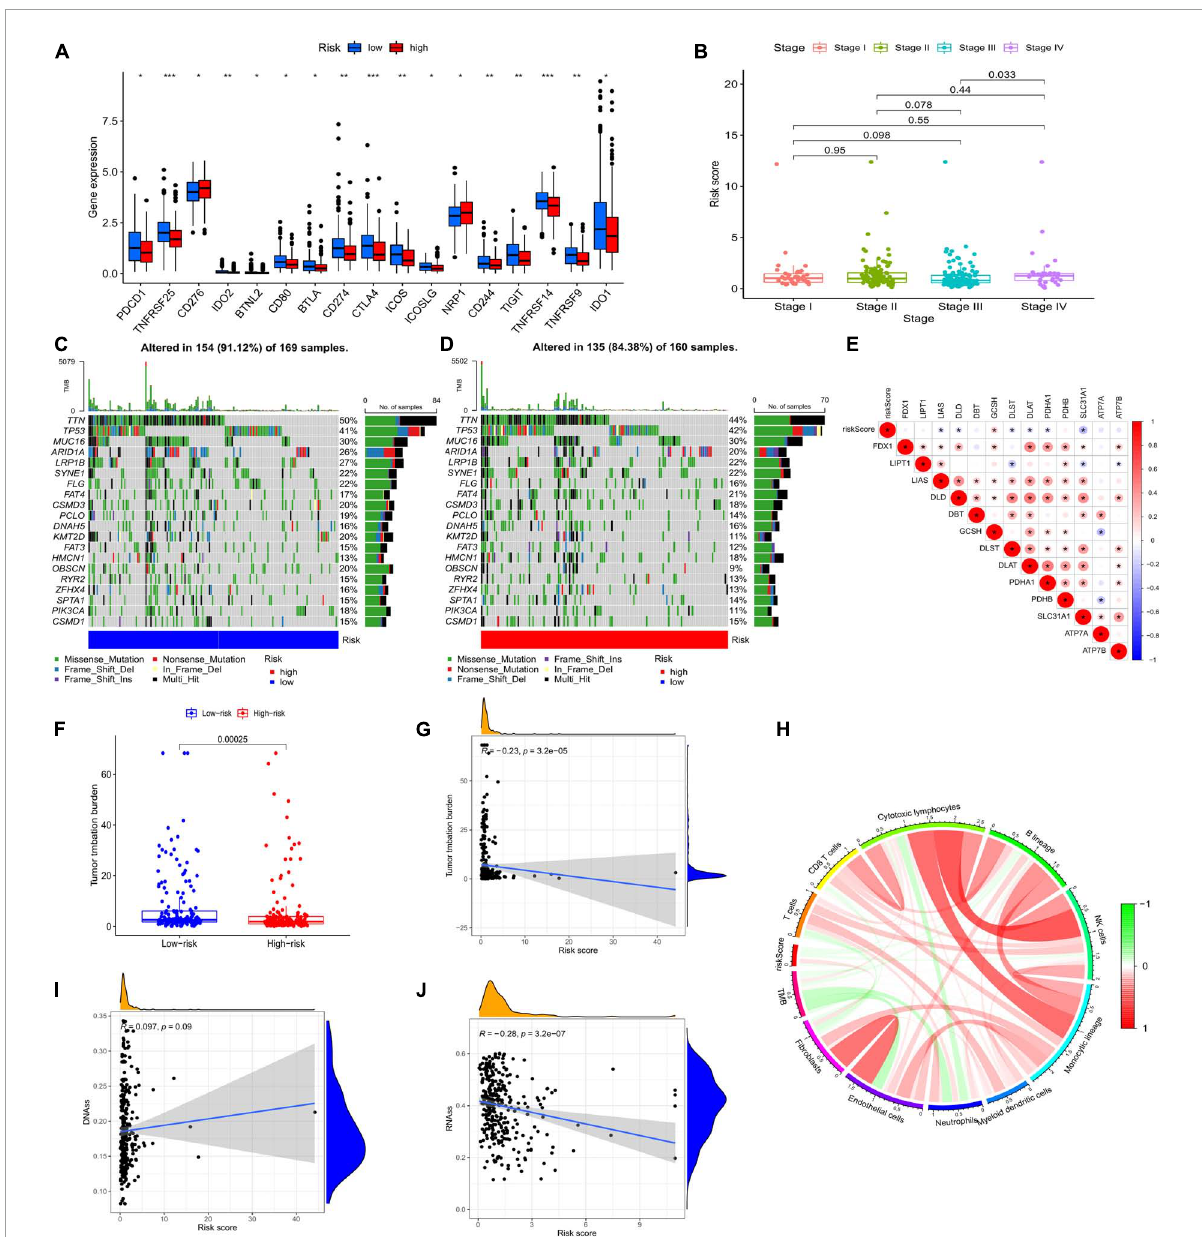
FIGURE7 (A) Expression of immune checkpoints in the two risk groups. (B) Clinical features of the model. Somatic mutations in the low-risk group (C) and the high-risk group (D) . (E) Association between risk score and CRGs. (F) TMB of the two risk groups. (G) The relationship between TMB and risk score. (I,J) Correlation between CSC and risk score. (H) Circle picture displaying the relationship between TMB and immune cells. CRGs, cuprotosis-related genes; TMB, tumor mutational burden; CSC, cancer stem cell;